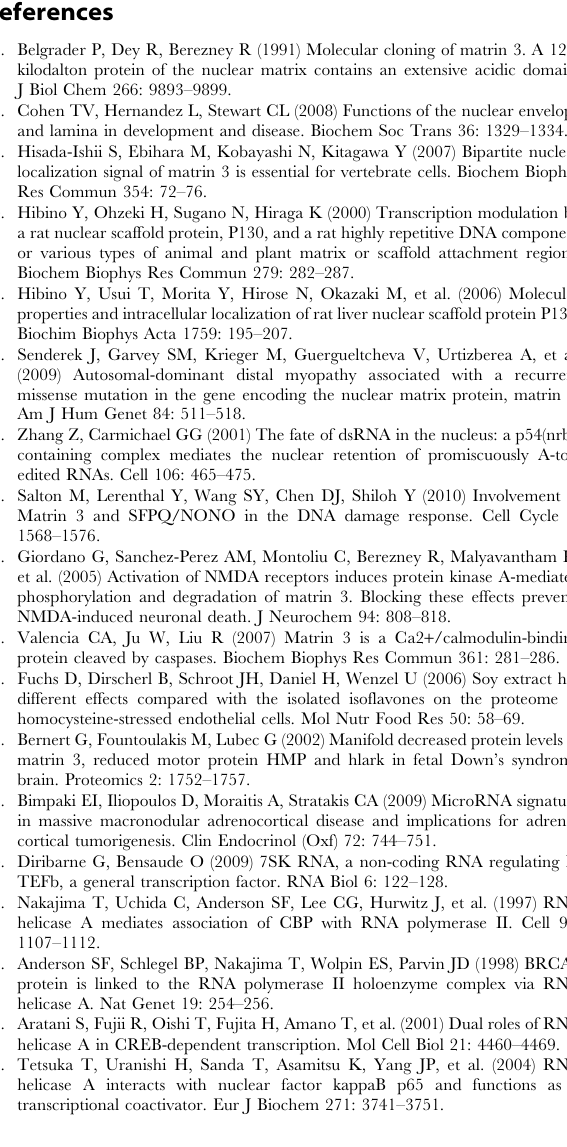
Table S1 77 genes whose expression levels were re- duced in MATR3-depleted cells. Table S2 Primers used for real-time PCR.